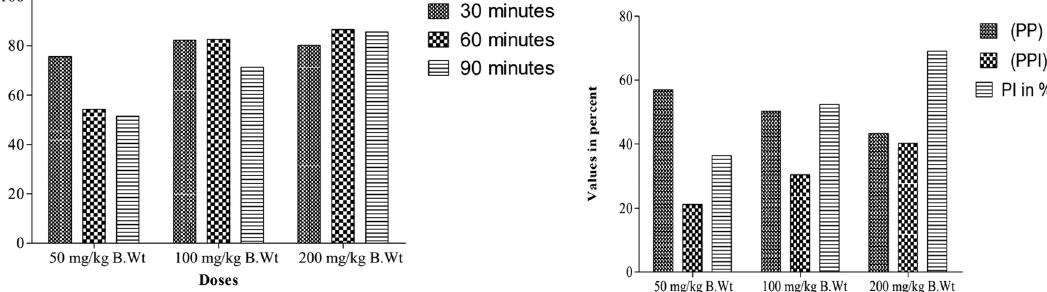
Figure 8: Analgesic e ffi cacy of SE - mediated AuNPs, showing analgesia ( percentage of diclofenac - Na ) under di ff erent dose concentrations and time durations.